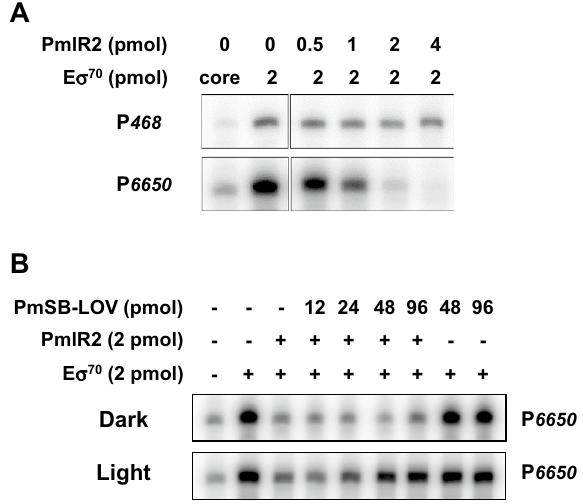
Figure 8. In vitro transcriptional runoff assay. ( A ) The assay for the repressor activity of PmlR2. Templates contained P 468 for the control and P 6650 including the PmlR2-binding site. ( B ) The anti-repressor activity of PmSB-LOV. P 6650 was used as a template. The RNA polymerase holoenzyme containing σ 70 (E σ 70 ) or its coreenzyme, PmlR2, and PmSB-LOV were added to the reaction mixture with 0.5 pmol template in the indicated amount, and the proteins were marked as presence (+) or absence (−). The generated transcripts for P 468 and P 6650 were analyzed by 6 M urea non-denaturing PAGE, followed by autoradiography. Two independent experiments in technical replicates were performed, and representative data were shown. The original and unprocessed versions of the full-length gels were included in Fig. S14 and S15.